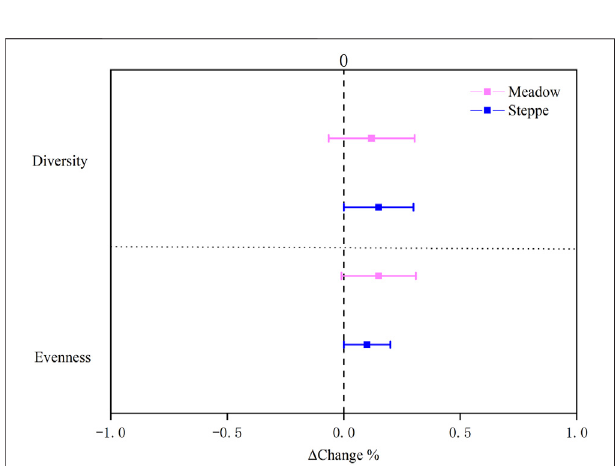
FIGURE 5 | Change in diversity and evenness in alpine meadow (red) and steppe (blue) grasslands from 2008 to 2018 in the permafrost region of the Tibetan Plateau. Relative change rate ( Δ Change) was calculated as the ratio of the absolute change to the mean value over the study period. Data were shown as estimate ±95% con fi dence intervals (CI). Data greater thanzerorepresentasigni fi cantincreaseinmeasuredvariable,andlowerthan zero represent a signi fi cant decrease between 2008 and